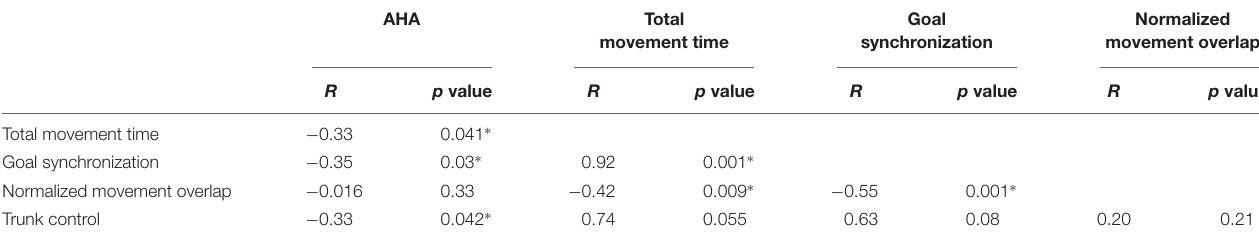
TABLE 3 | Correlation analyses between AHA scores and kinematic measures. AHA Total Goal Normalized movement time synchronization movement